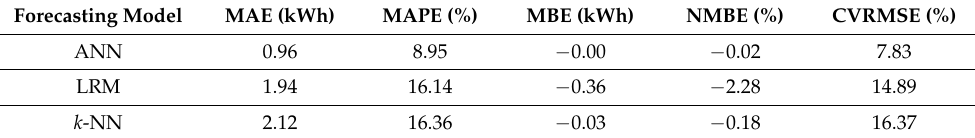
Table 3. Comparison of error criteria for three machine-learning algorithms. Forecasting